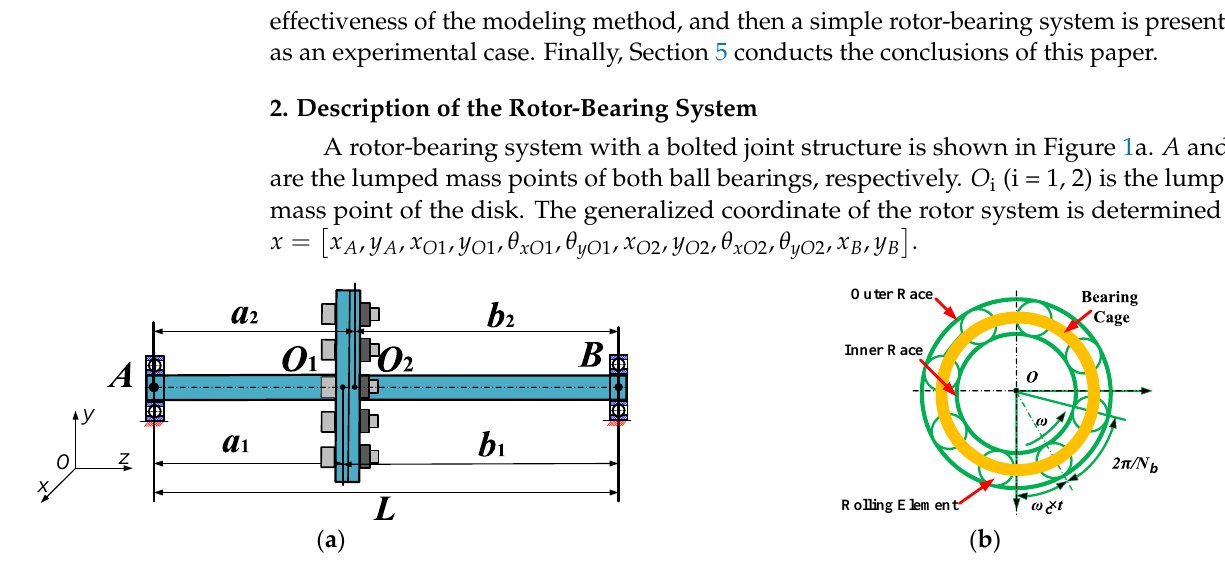
Figure 1. Schematic of the rotor-bearing system [33]: ( a ) rotor system; ( b ) ball bearing. Figure 1b is the ball bearing which consists of the inner race, outer race, bearing